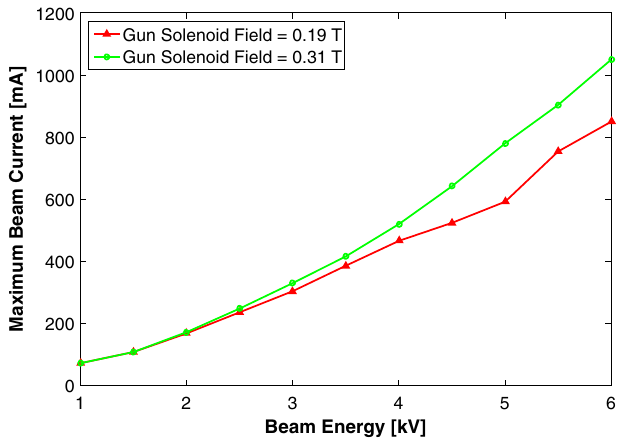
FIG. 12. Measurement of drift space perveance with different GS1 currents.